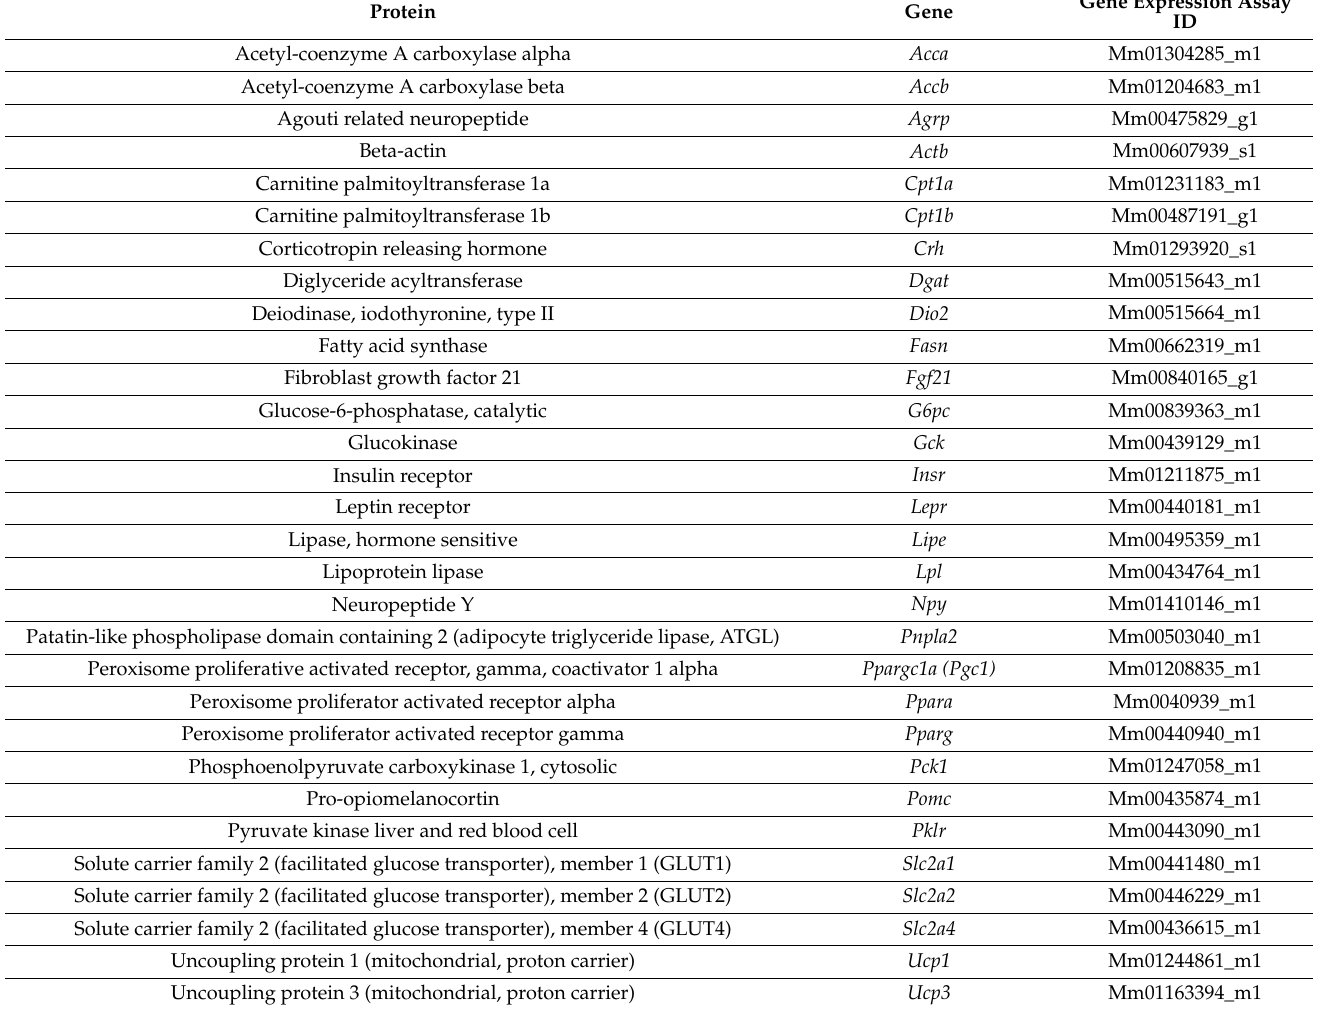
Table 4. TaqMan Gene expression assays used for relative quantitation real-time PCR. Protein Gene Gene Expression Assay